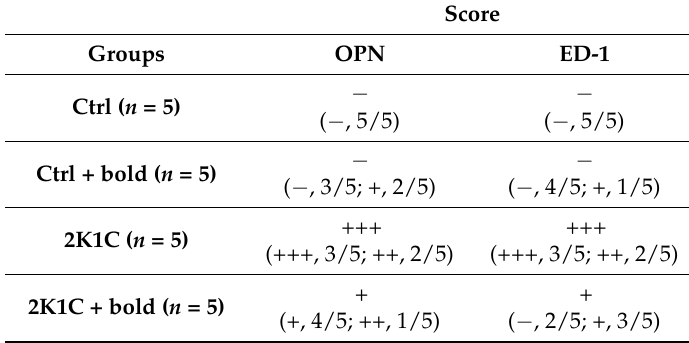
Table 3. Immunoreactivity score for OPN and ED-1 from the tissue samples from rats of the four experimental groups. The semi-quantitative morphometric analysis for OPN and ED-1 was performed on a scale of negative to three crosses ( − to +++), defined according to the degree of immunoreactivity observed in the renal tissue sample ([ − ] = 0–10%, [+] = 10–40%, [++] = 40–70% and [+++] =